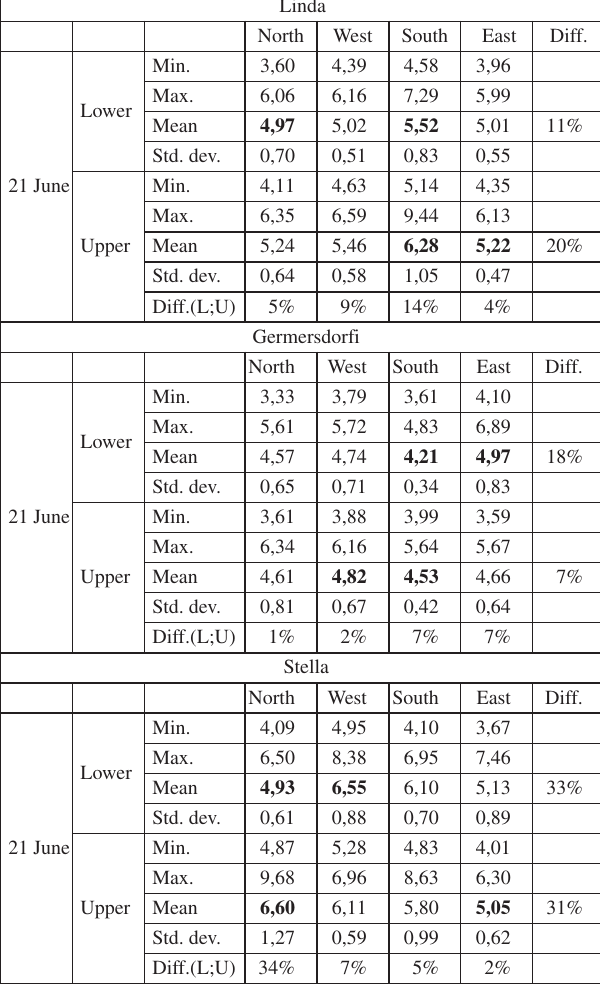
Table 4: The values of the stone-pulp ratio Linda North West East